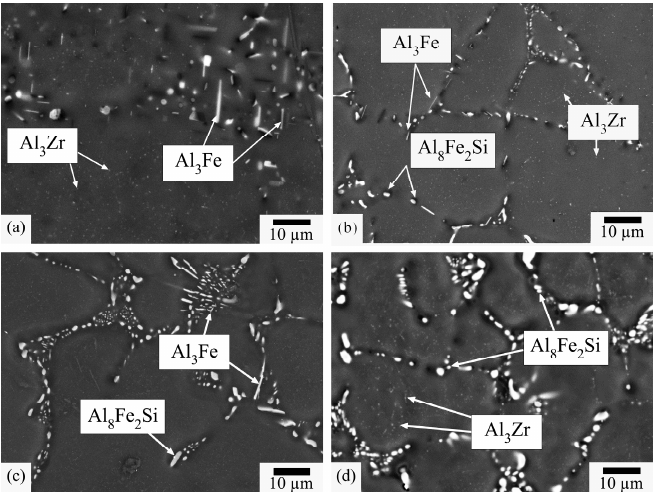
Figure 4. Microstructure of Al-1%Fe-Si-0.3%Zr alloys annealed at S600 with different contents of Si: ( a ) Al-1% Fe-0.3% Zr; ( b ) Al-1% Fe-0.25% Si-0.3% Zr; ( c ) Al-1% Fe-0.5% Si-0.3% Zr; ( d ) Al-1% Fe-1% Si-0.3% Zr.